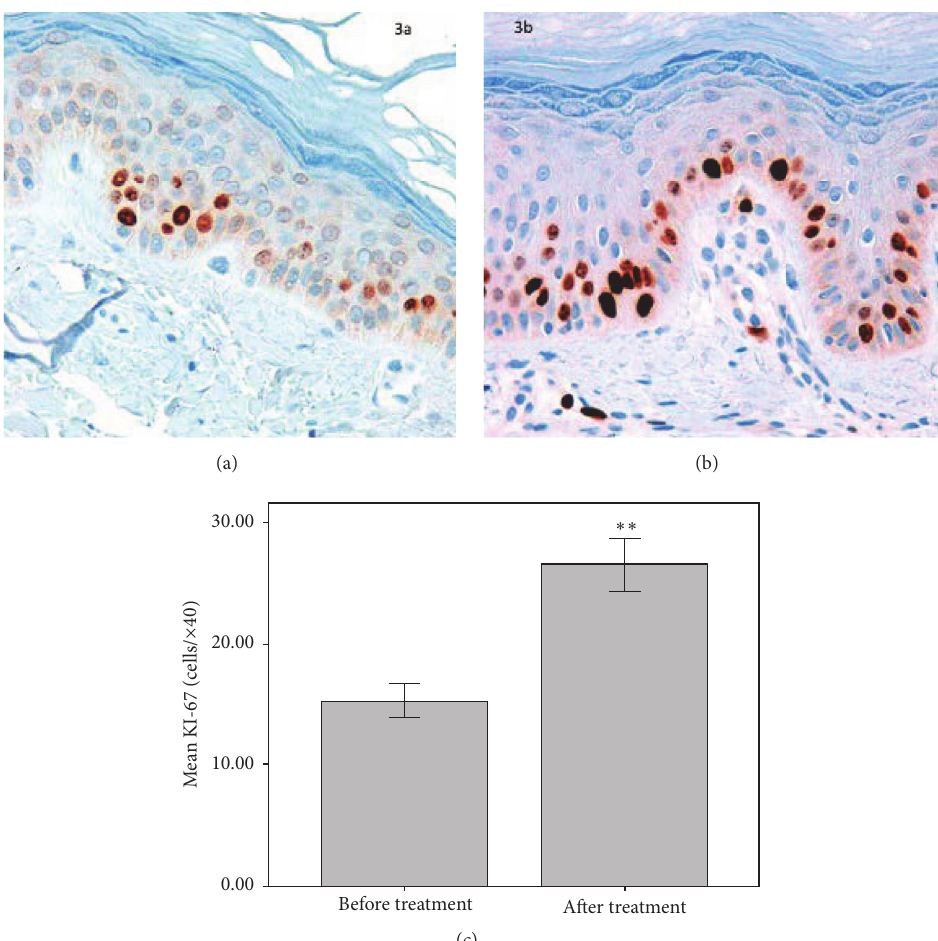
Figure 3: Immunohistochemical staining with Ki67 proliferation marker, before (a) and after (b) treatment showing the improvement of the proliferation index (40x magnification) at the end of the study. Quantification of Ki67 positive cells showed a 73.2% increase after treatment compared to baseline ( ∗∗ 𝑝 ≤ 0.01 )